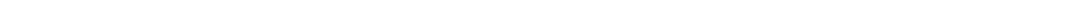
(see fi gure on previous page) Fig. 5 STX17 is a downstream target of Xist - miR-23b-3p / miR-29a-3p axis and regulates PF formation. a The Venn diagram shows overlapping of the co-target genes of miR-23b-3p / miR-29a-3p from fi ve representative databases. b The predicted binding sites of miR-23b-3p and miR-29a-3p binding sites in the 3 ′ -UTR of Stx17 . The red nucleotides represent mutant sequences of target sites. c Luciferase activities in HEK293 cells transfected with WT or mutant Stx17 plasmid together with miR-23b-3p or miR-29a-3p , or miR-NC . d Enrichment of Stx17 pulled down by biotin- miR-23b-3p , biotin- miR-29a-3 , or biotin- miR-NC control in 3T3 cells. e – h Relative Stx17 mRNA (left), and STX17 protein (right) expression in cultured newborn ovaries transfected with mimics for miR-23b-3p , miR-29a-3p , or miR-NC ( e ), anti- miR-23b-3p , anti- miR-29a-3p , or anti- miR-NC ( f ), Xist or empty control ( g ), and si Xist or scrambled control ( h ). i Relative Stx17 mRNA (left), and STX17 protein (right) expression at the indicated time points. j Relative Stx17 mRNA (left), and STX17 protein (right) expression in cultured newborn ovaries transfected with si Stx17 , or si NC as a control. k Representative images (left) and quanti fi cation of follicles (right) in newborn ovaries transfected with si Stx17 , or si NC . Scale bars: 50 μ m. l qRT-PCR analysis of genes involved in PF survival and development in newborn ovaries transfected with si Stx17 , and si NC as a control. m WB analysis of LC3B expression in newborn ovaries treated under indicated condition. n Representative images of DDX4 in newborn ovaries co-transfected with pcDNA- Xist or empty vector together with siStx17 or scrambled control. Scale bars: 50 μ m. o Quanti fi cation of follicles in n . p WB analysis of STX17 expression in newborn ovaries treated under indicated condition. GAPDH was used as a loading control. Student ’ s t -test: * P < 0.05, ** P < 0.01, *** P <